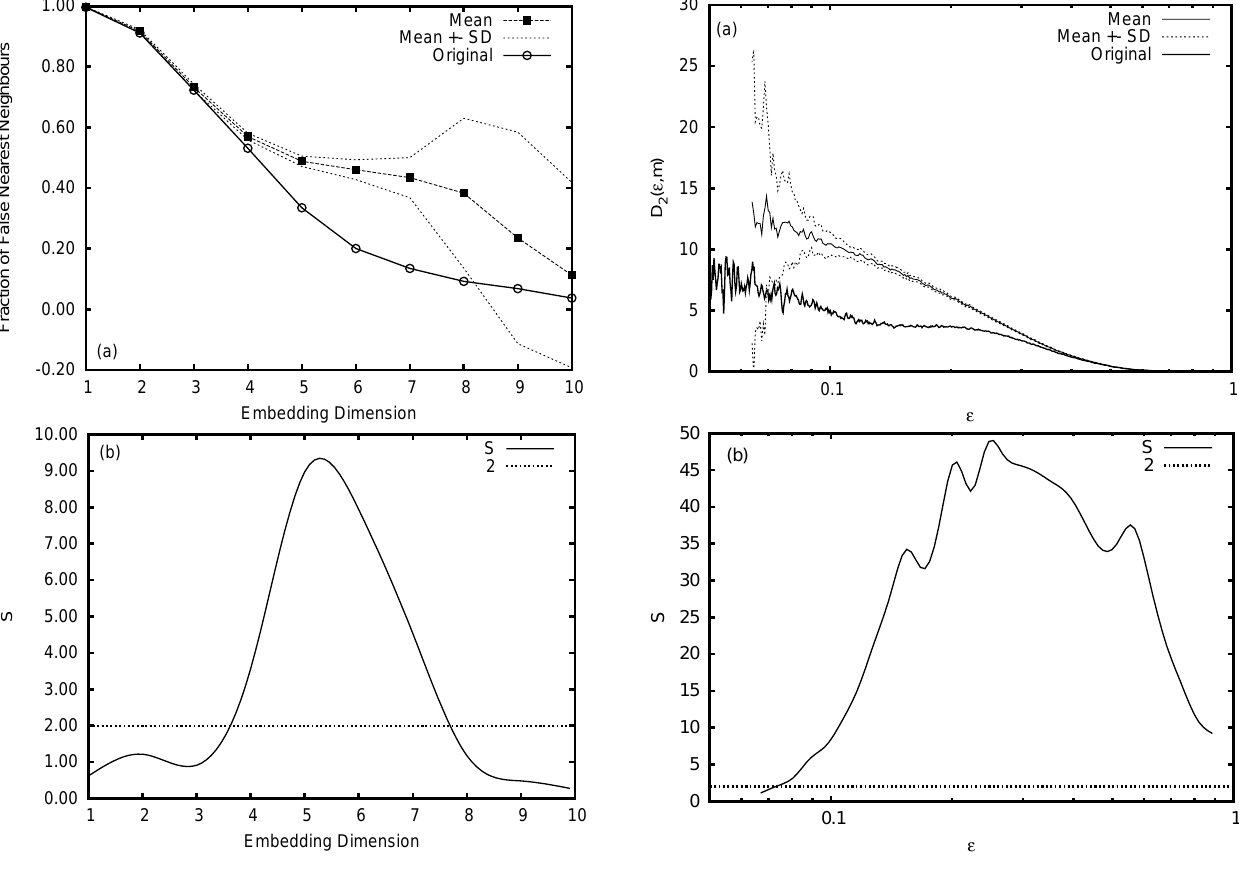
Fig. 13. (a) The mean values of the local slopes of the surrogates with standard deviation. (b) Plot of the significance of difference S versus (cid:15) . Here the normalised data sets are used, and m = 14 ,τ = 1 , and ω =